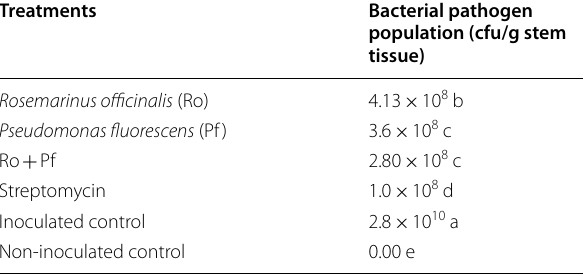
Values in the column followed by different letters indicate significant differences among treatments according to a least significant differences test ( P